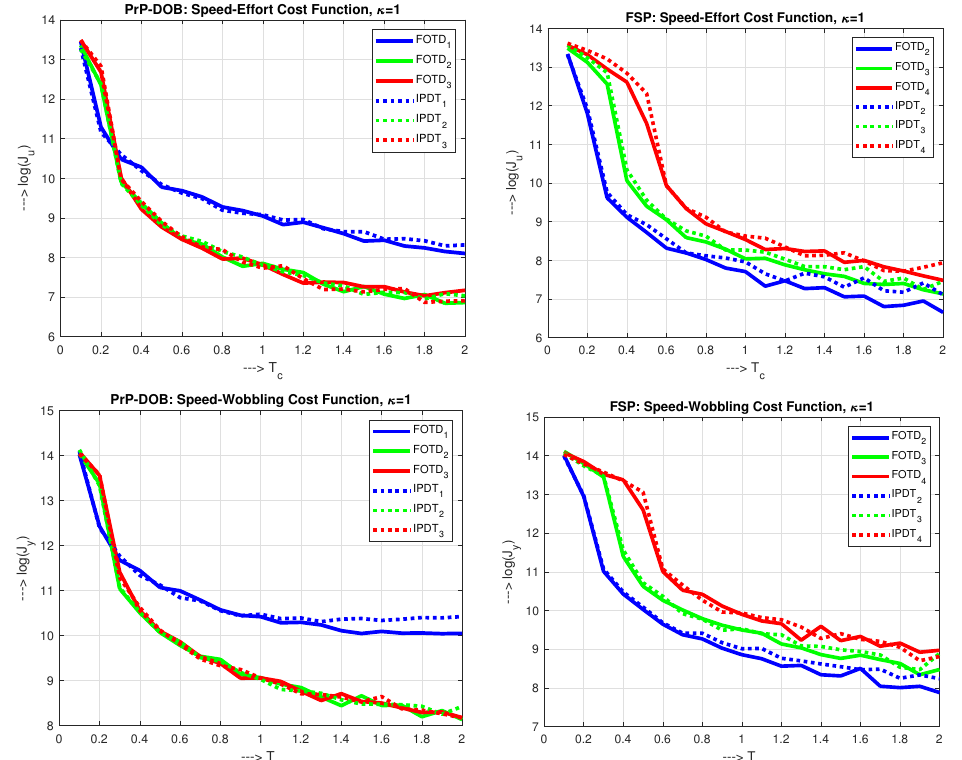
Figure 15. PrP-DOB controller (Equation (26)) combined with filtration according to Figures 1 and 5, λ = − n / T c ( left ) and FSP controller (Equations (39)–(52)) ( right) . Speed-effort ( above ) and speed- wobbling cost functions (below) versus the tuning parameter T c ∈ [ 0.1,2 ] s; κ =